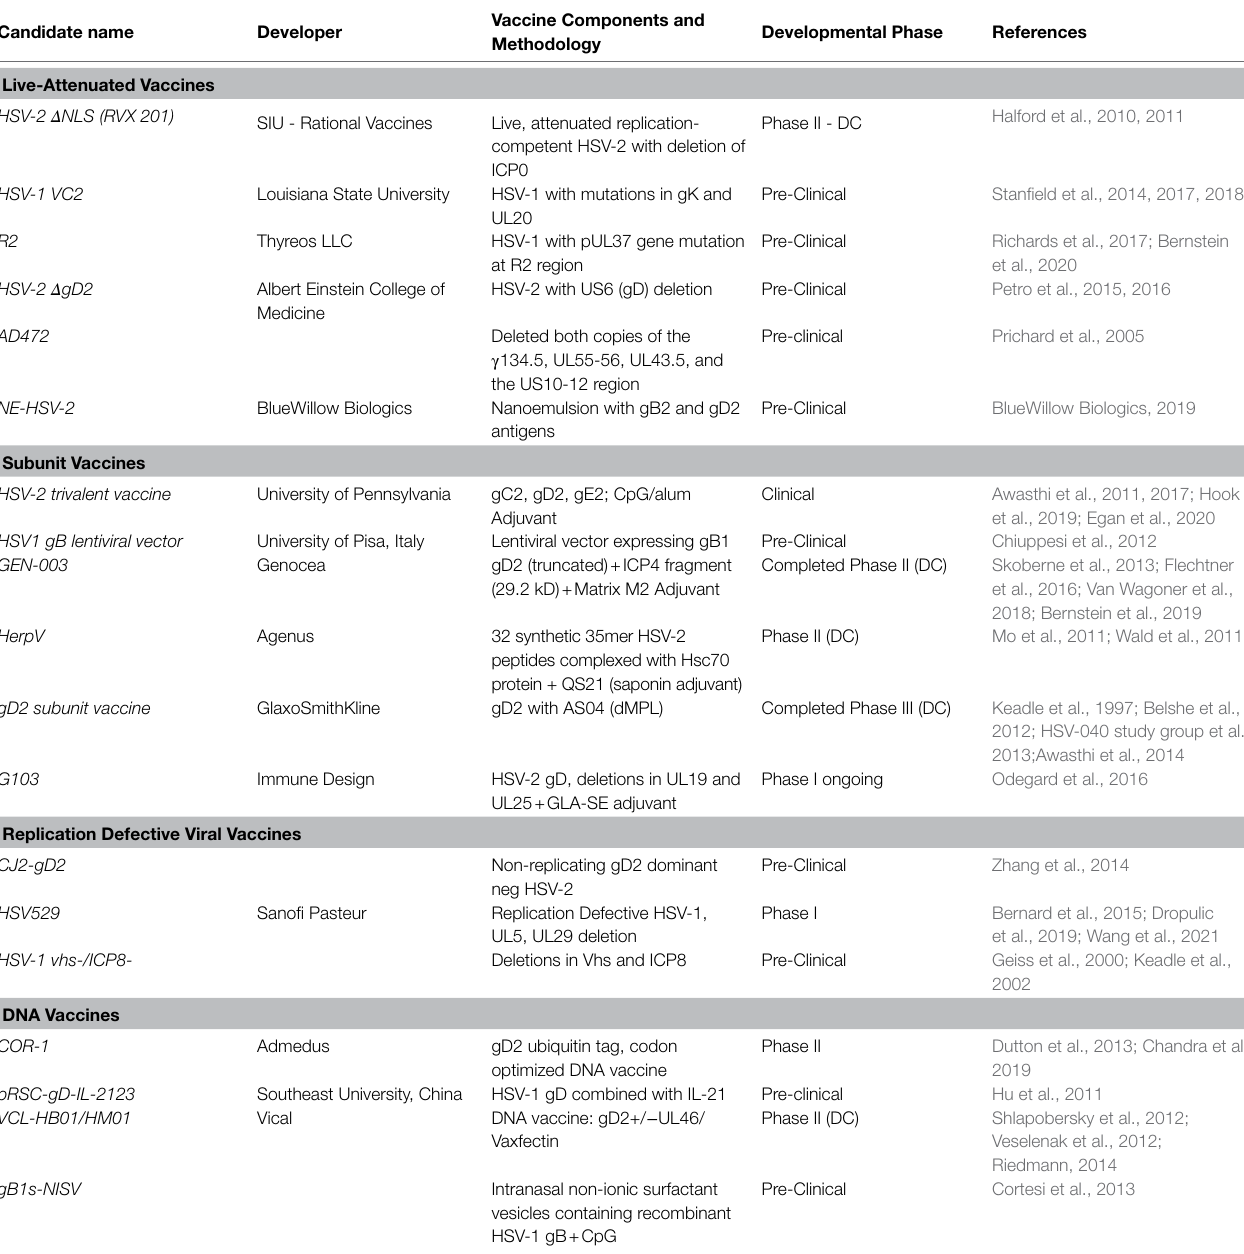
TABLE 1 | Vaccines in development for infection with